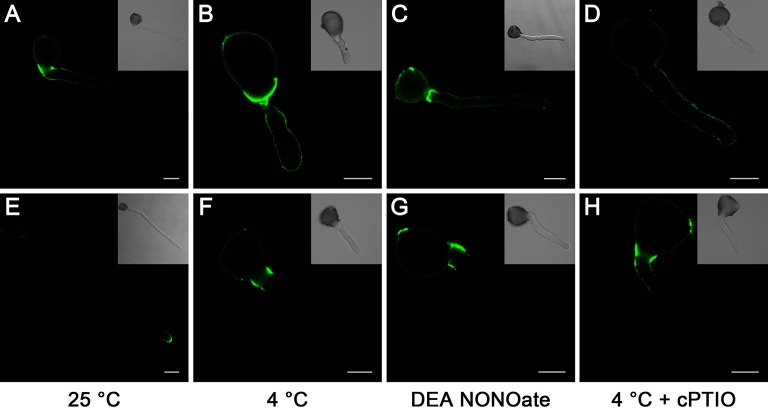
Effects of cold stress and DEA NONOate on the distribution of acidic pectins and esterified pectins in the pollen tube cell wall of C. sinensis. LM19 labeling of the control pollen tubes observed by LSCM showed that strong fluorescence occurred in the basal site of the tube wall and decreased gradually toward the tip region of the pollen tube (A), but fluorescence occurred along the entire pollen tube wall, including the tip region, in the pollen tubes treated with cold stress (B), or 25 μM DEA NONOate (C). The fluorescence signal of the LM19 labeled acidic pectins at the pollen tube tip was decreased by 200 μM cPTIO under cold stress (D). LM20 labeling of the control pollen tubes observed by LSCM showed that the esterified pectins localized to the tip region of the pollen tubes (E). LM20 labeling of the pollen tubes treated with cold stress or 25 μM DEA NONOate observed by LSCM showed that the esterified pectins accumulated only in the basal region near the germinating aperture (F,G). Treatment with 200 μM cPTIO increased the distribution of esterified pectins on the shank of the pollen tubes but was still not detected in the pollen tube tip region (H). Corresponding bright field images are shown at a reduced size. At least 20 pollen tubes were observed and photographed in each of three replicates, and one representative image per treatment was displayed. Bar = 20 μm.